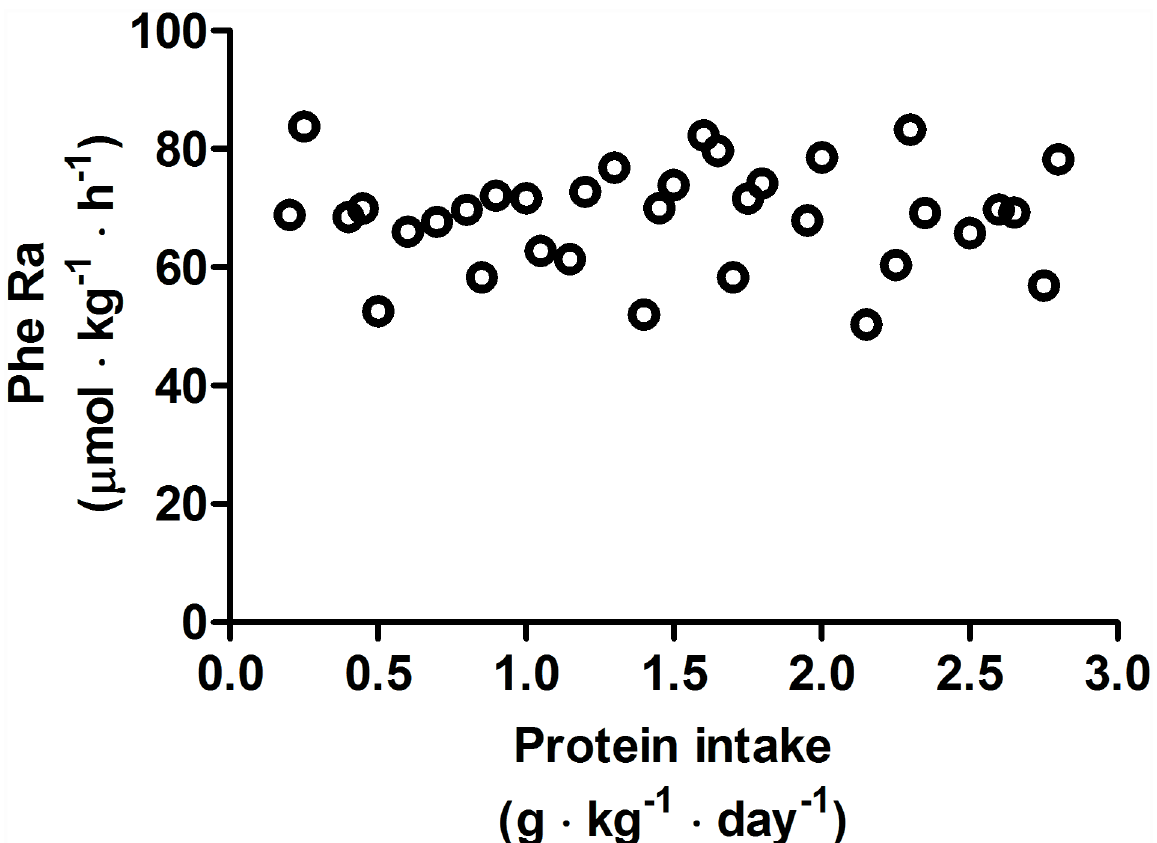
Fig 2. Relationship between Phenylalanine Ra and protein intake after exercise stimulus. Each data point represents PheRa on the individual metabolic trial day. The slope of regression line was not significantly different from zero (P = 0.11).